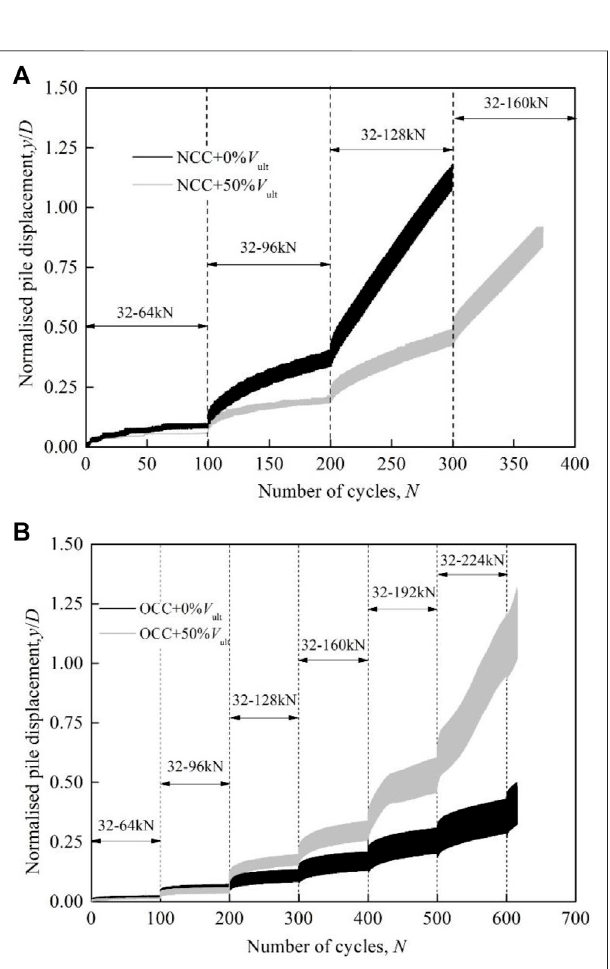
FIGURE5| Cumulativelateraldisplacementofthepileinthe (A) NCclay; (B) OC